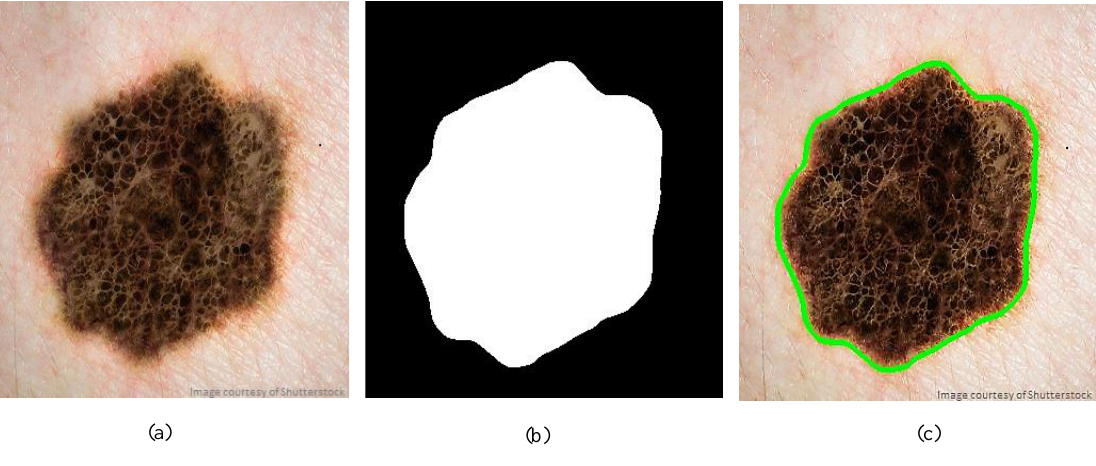
Figure 2. Sample segmentation of skin lesions: ( a ) Original dermoscopy image, ( b ) Binary mask, ( c ) Traced skin